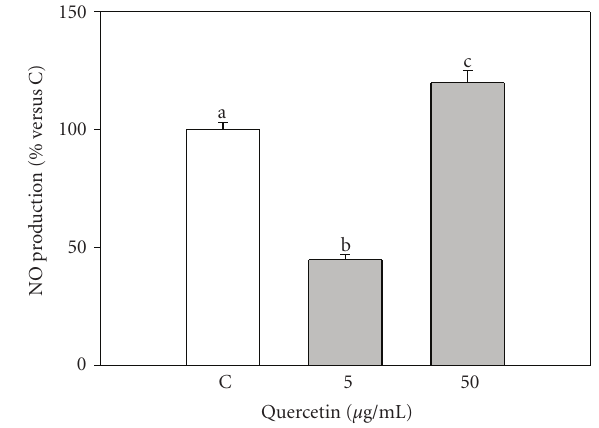
Figure 1: E ff ect of the 48-hour treatment with quercetin (5 and 50 μ g/mL) on Estradiol 17 β (E2) production by swine granulosa cell cultured in vitro. Data represent the mean ± SEM of six replicates/treatment repeated in four di ff erent experiments. Di ff er- ent letters indicate significant di ff erences ( P < . 001) calculated by ANOVA and Sche ff `e’s F-test (Statgraphics package, STSC Inc., Rockville, Md, USA).